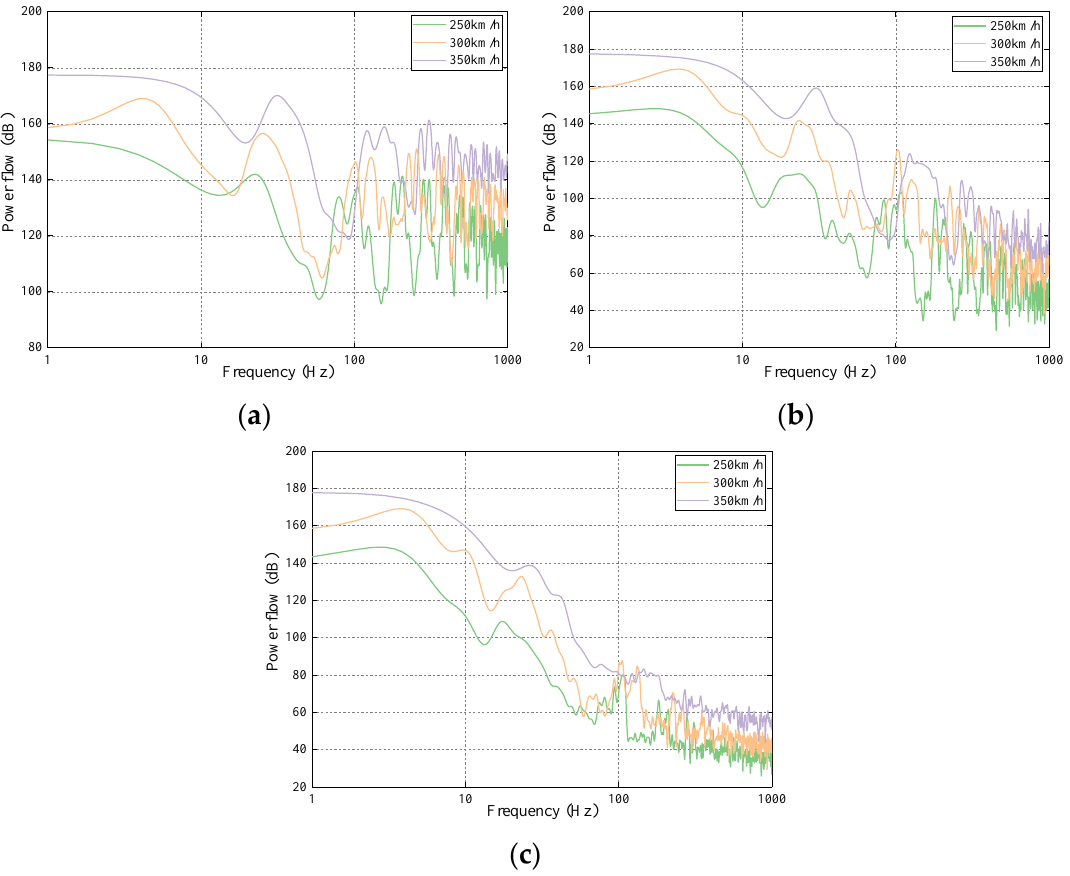
Figure 13. The power flows of ( a ) the rail, ( b ) the slab track, and ( c ) the bridge. Figure 15. The power flows of ( a ) the rail, ( b ) the slab track, and ( c ) the